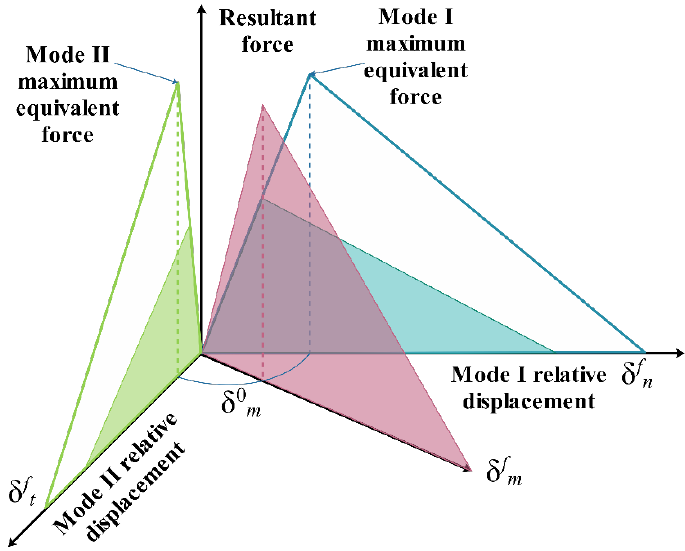
Figure 6. A bilinear mixed-mode traction–separation law.